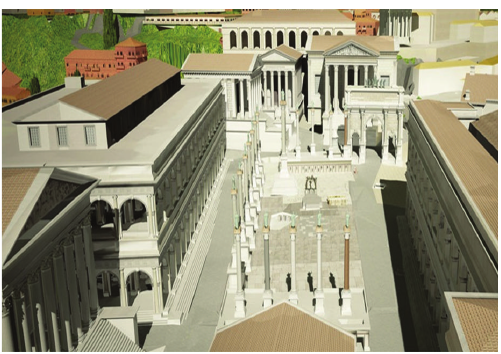
Figure 6: The Roma Nova